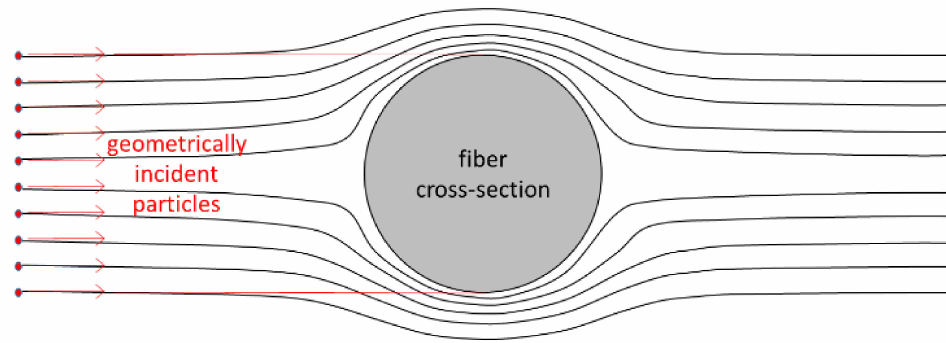
Figure A3. Single fiber flow field stream lines.